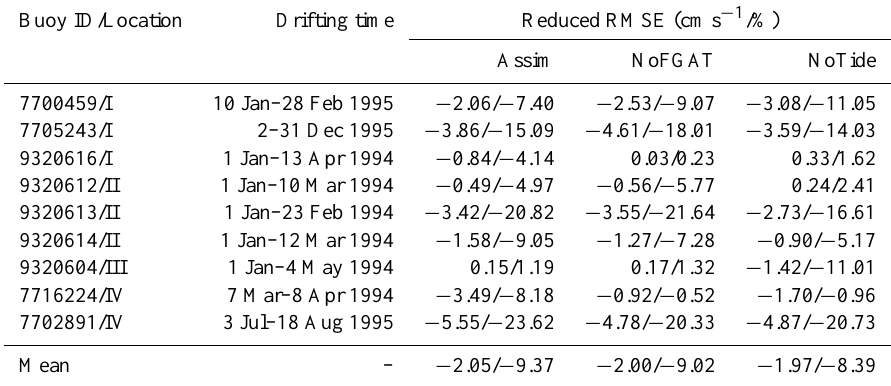
Table 3. Velocity RMSE reduction between the simulated surface current and the daily velocities observed by drifters when data assimilation is used (RMSE(Assim)–RMSE(Ctrl)) and its reduction percent relative to the RMSE in Ctrl (see Eq.